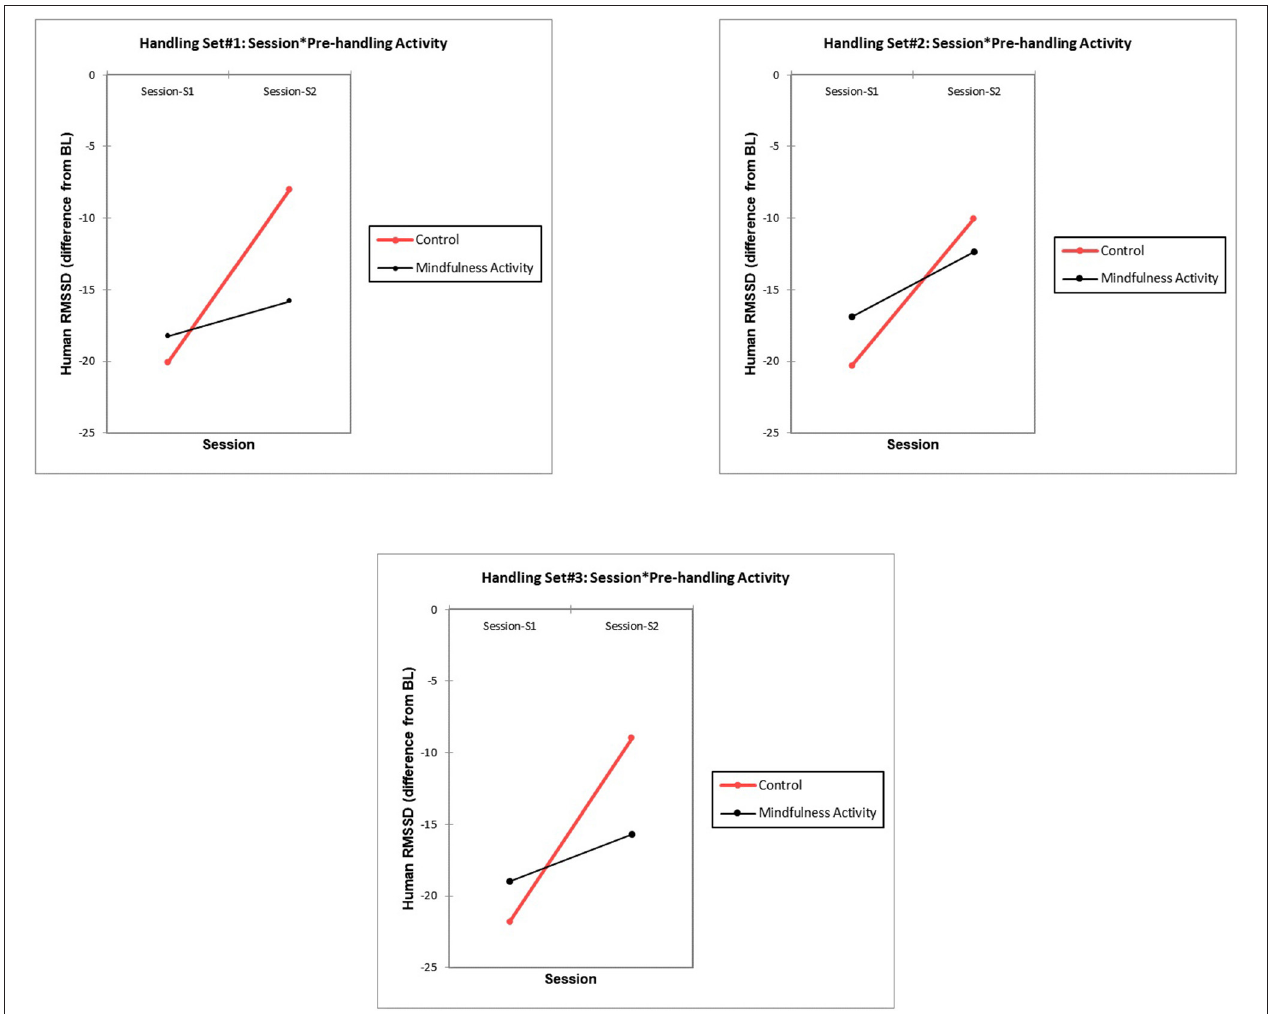
FIGURE 5 | Means plots for RMSSD (human) for the three handling sets, by session (1 vs. 2) and pre-handling exercise (mindfulness vs. control), illustrating the significant interaction effect between session and pre-handling activity. Statistical significance for the interaction effect can be found in the text, and in the Supplementary Material